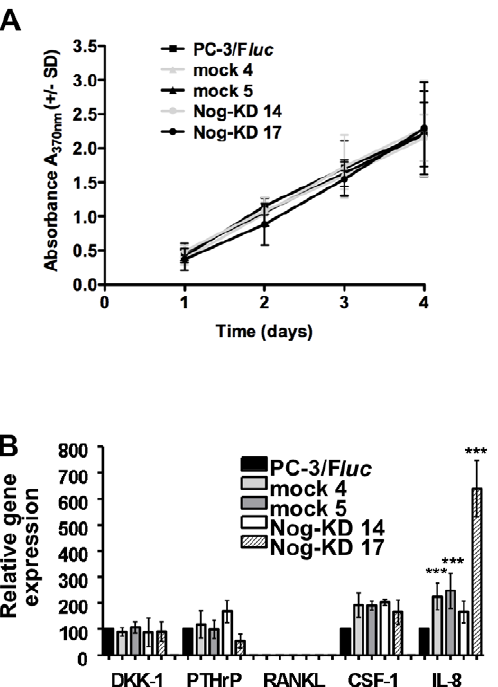
Figure 2. Noggin silencing has no effect on cell proliferation and affects only minimally the expression of osteotropic factors, invitro . A . In vitro proliferation of mock and Nog-KD clones was measured by BrdU incorporation for 4 days and compared to PC-3/ F luc cells. Average values of 3 independent experiments performed in quadruplicate wells ( + / 2 SD). B . Expression of Dkk-1, PTHrP, RANKL, CSF-1 and IL-8 mRNA. mRNA expression levels ( + / 2 SD) are quantified by real-time RT-PCR and normalized to b -actin as endogenous control. The mRNA expression level in PC-3/F luc cells is set as 100%; the mean of 2 to 3 independent experiments is shown. ***P , 0.001, mock and Nog- KD 17 clones versus PC-3/F luc and Nog-KD 14 clones.